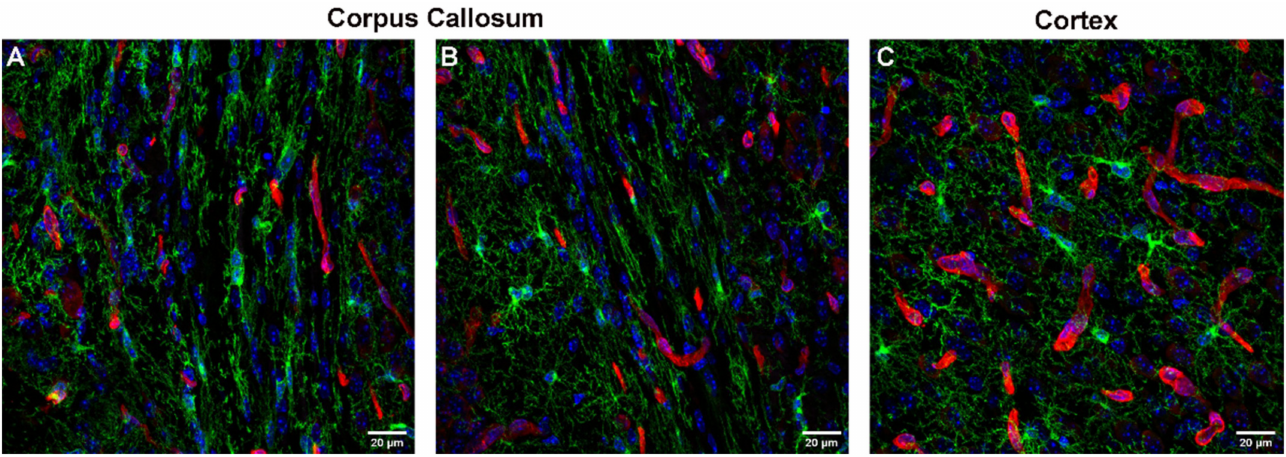
Figure 3. OPCs (green, immunolabeled with a goat antibody detecting mouse PDGFR α ) in relation- ship to blood vessels (red, immunolabeled with a rabbit antibody detecting laminin) in the mouse corpus callosum ( A , B ) and cortex ( C ). DAPI staining is shown in blue. Scale bars represent 20 µ